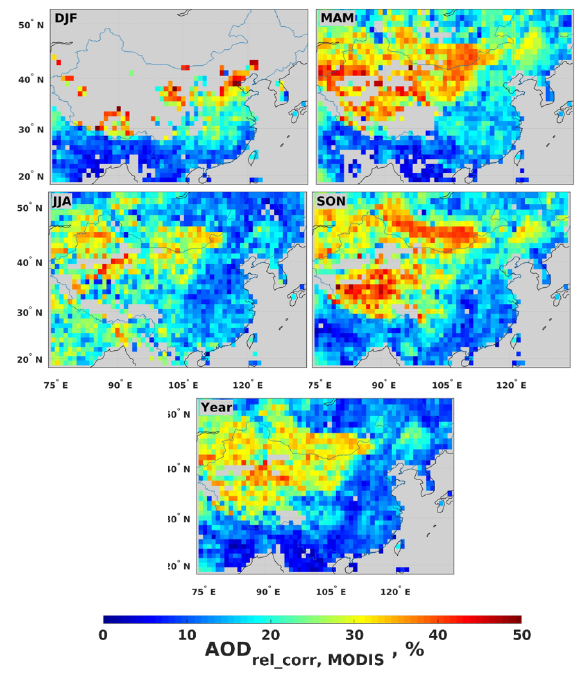
Figure 3. AOD relative correction for MODIS seasonal (DJF, MAM, JJA and SON) and annual (Year) AOD for the combined AOD dataset obtained using the method introduced in Sect.